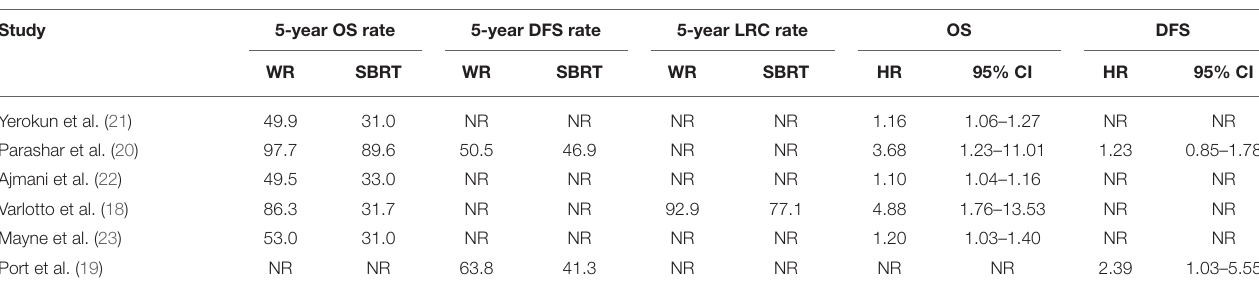
TABLE 2 | Main outcomes extracted from the selected studies.